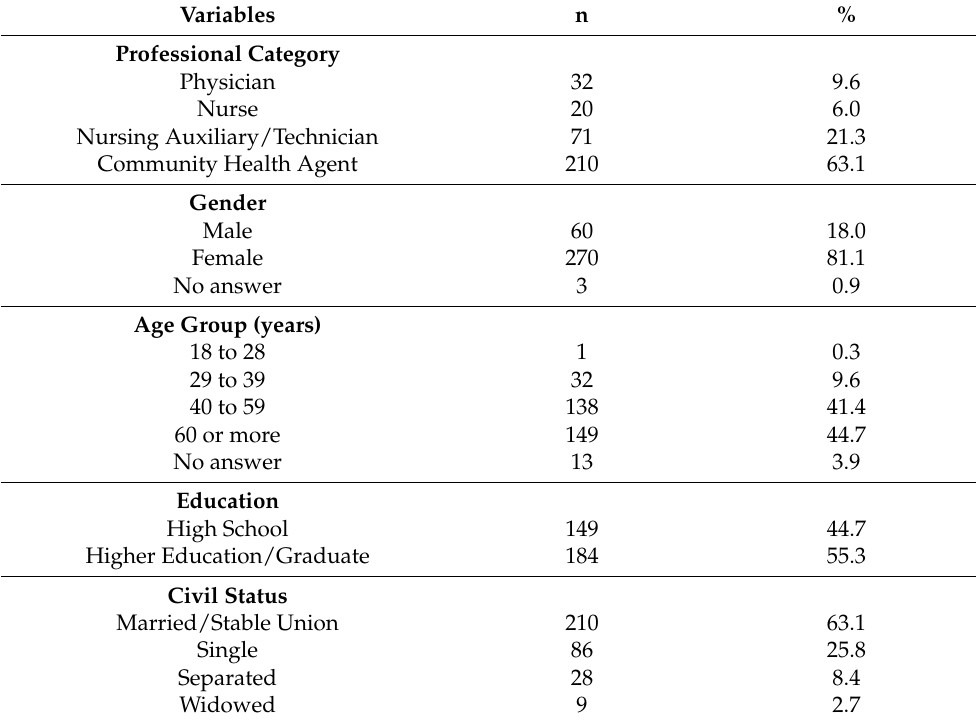
Table 1. Sociodemographic and professional characteristics of primary healthcare (PHC) workers